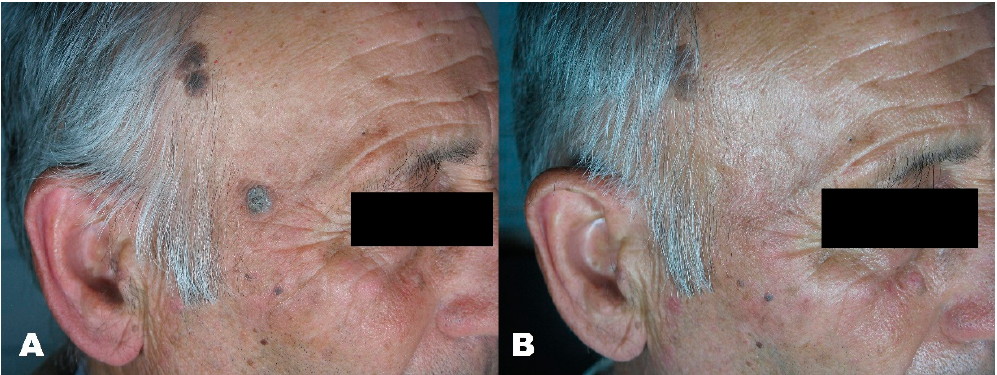
Figure 1. ( A ) Seborrheic keratosis before treatment. ( B ) Region after removal with Erbium laser.